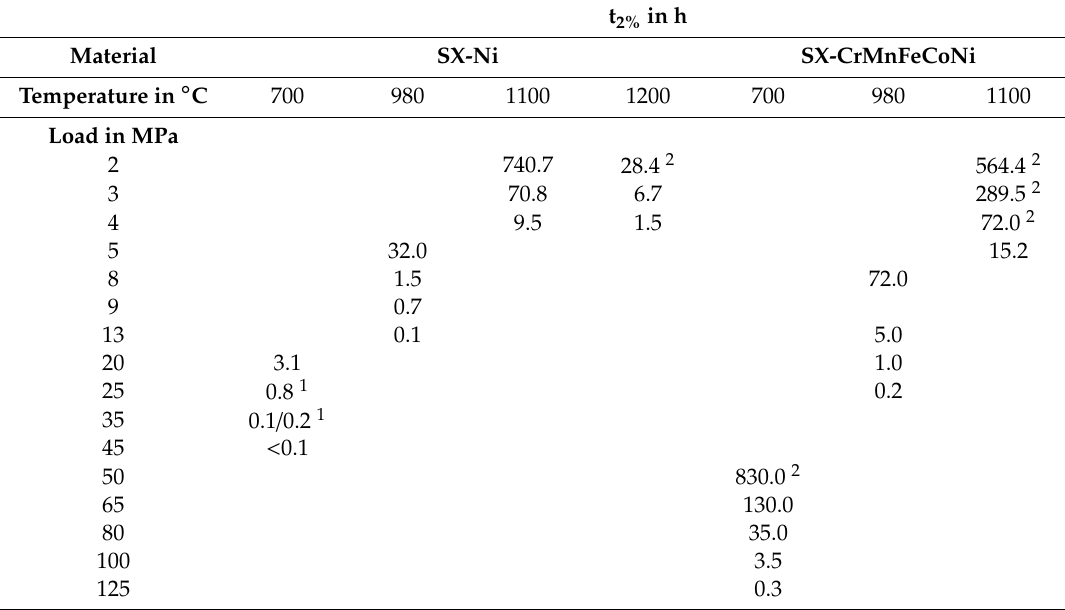
Table 2. Time to reach 2% strain for the creep tests in pure nickel and CrMnFeCoNi at di ff erent loads and temperatures under vacuum. t 2% in h Material SX-Ni SX-CrMnFeCoNi Temperature in ◦ C 700